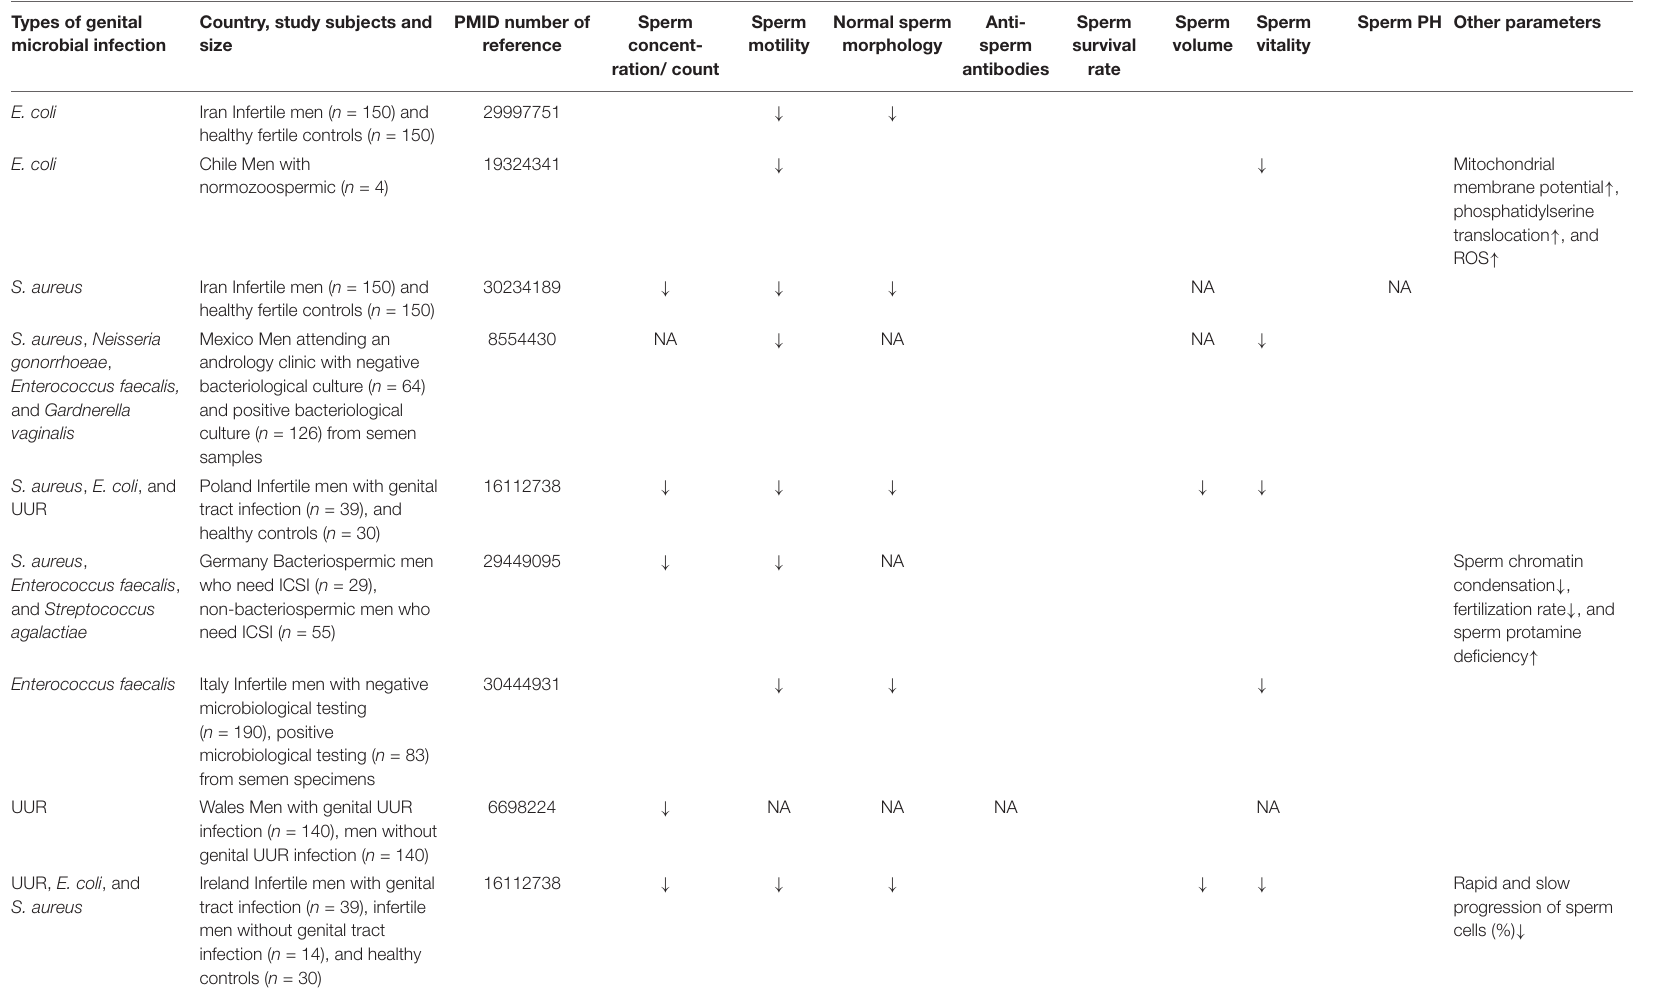
TABLE 1 | Effects of genital microbial infection on